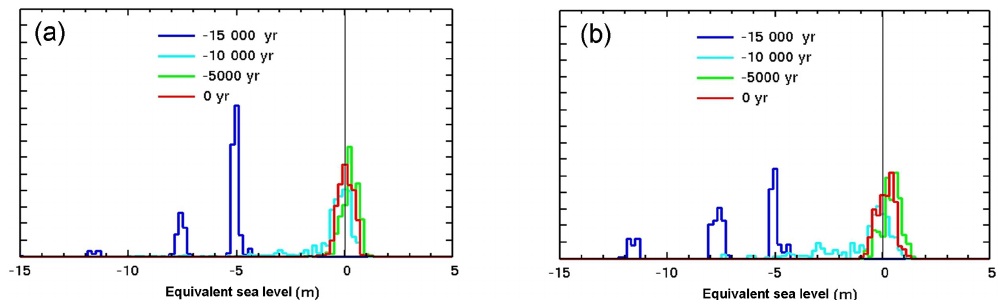
Figure C5. Probability densities of equivalent sea-level (ESL) rise at particular times as in Fig. 6. (a) Using the close-to-Gaussian scoring approach (a) (Sect. 2.4, Appendix B). (b) Using the more heuristic approach (b) (Sect. 2.4, Appendix B), exactly as in Fig.